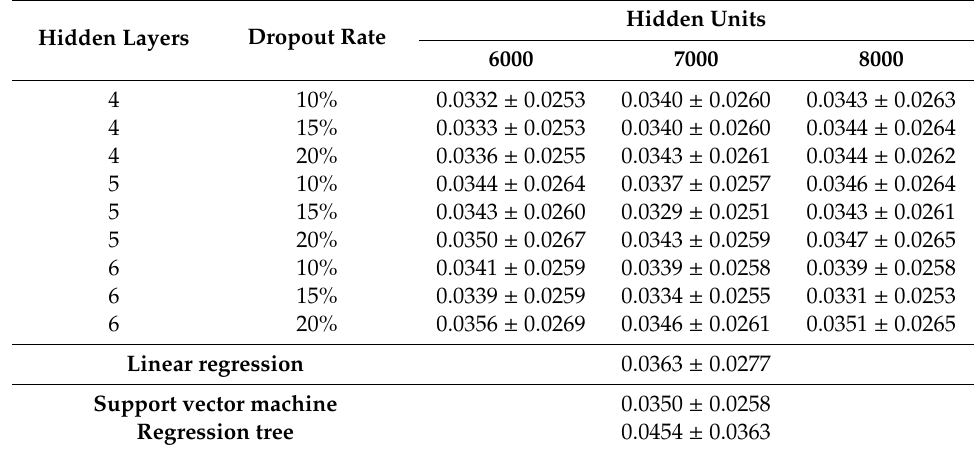
Table 2. The mean absolute error (MAE)-based overall errors of linear regression (LR), the regression tree (RT), the support vector machine (SVM), and D-GPM, with partially di ff erent architectures (hidden layer: from 4 to 6, with step size 1; hidden unit: from 6000 to 8000, with step size 1000; dropout rate: from 10% to 20%, with step size 5%) for MBV-te. The numbers before “ ± ” are the overall MAE for all the target genes. The numbers after “ ± ” are the standard deviations of the predicted MAE over all the target genes. The best MAE performance of D-GPM is underlined. SD refers to the standard